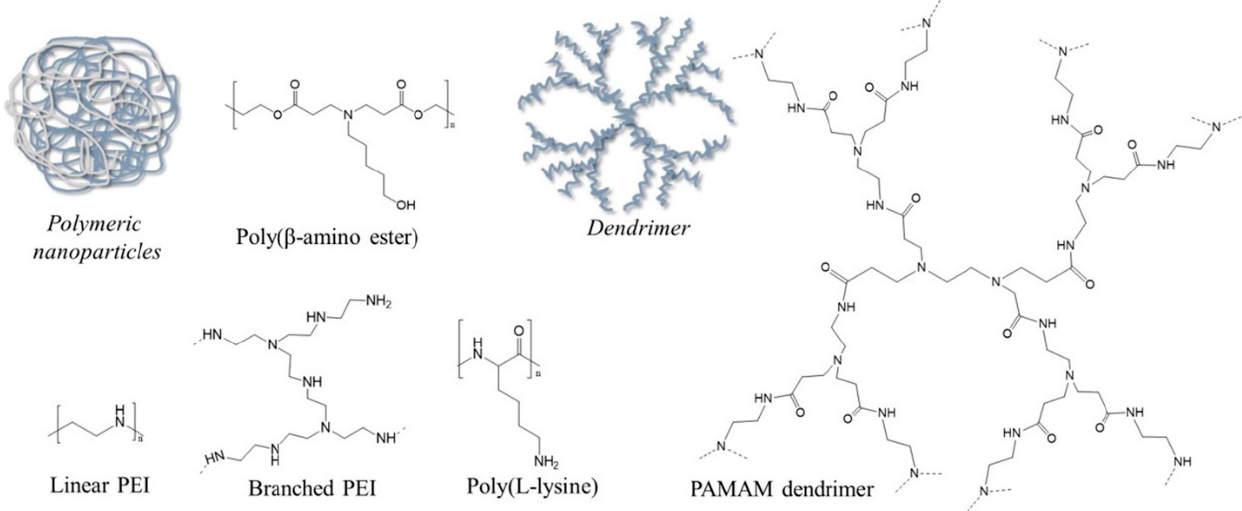
Figure 1. Chemical structure of the most commonly used polyplexes as non ‐ viral vectors in gene therapy drug delivery studies and clinical trials. PEI and PLL are among the oldest and the most used non ‐ viral vectors.